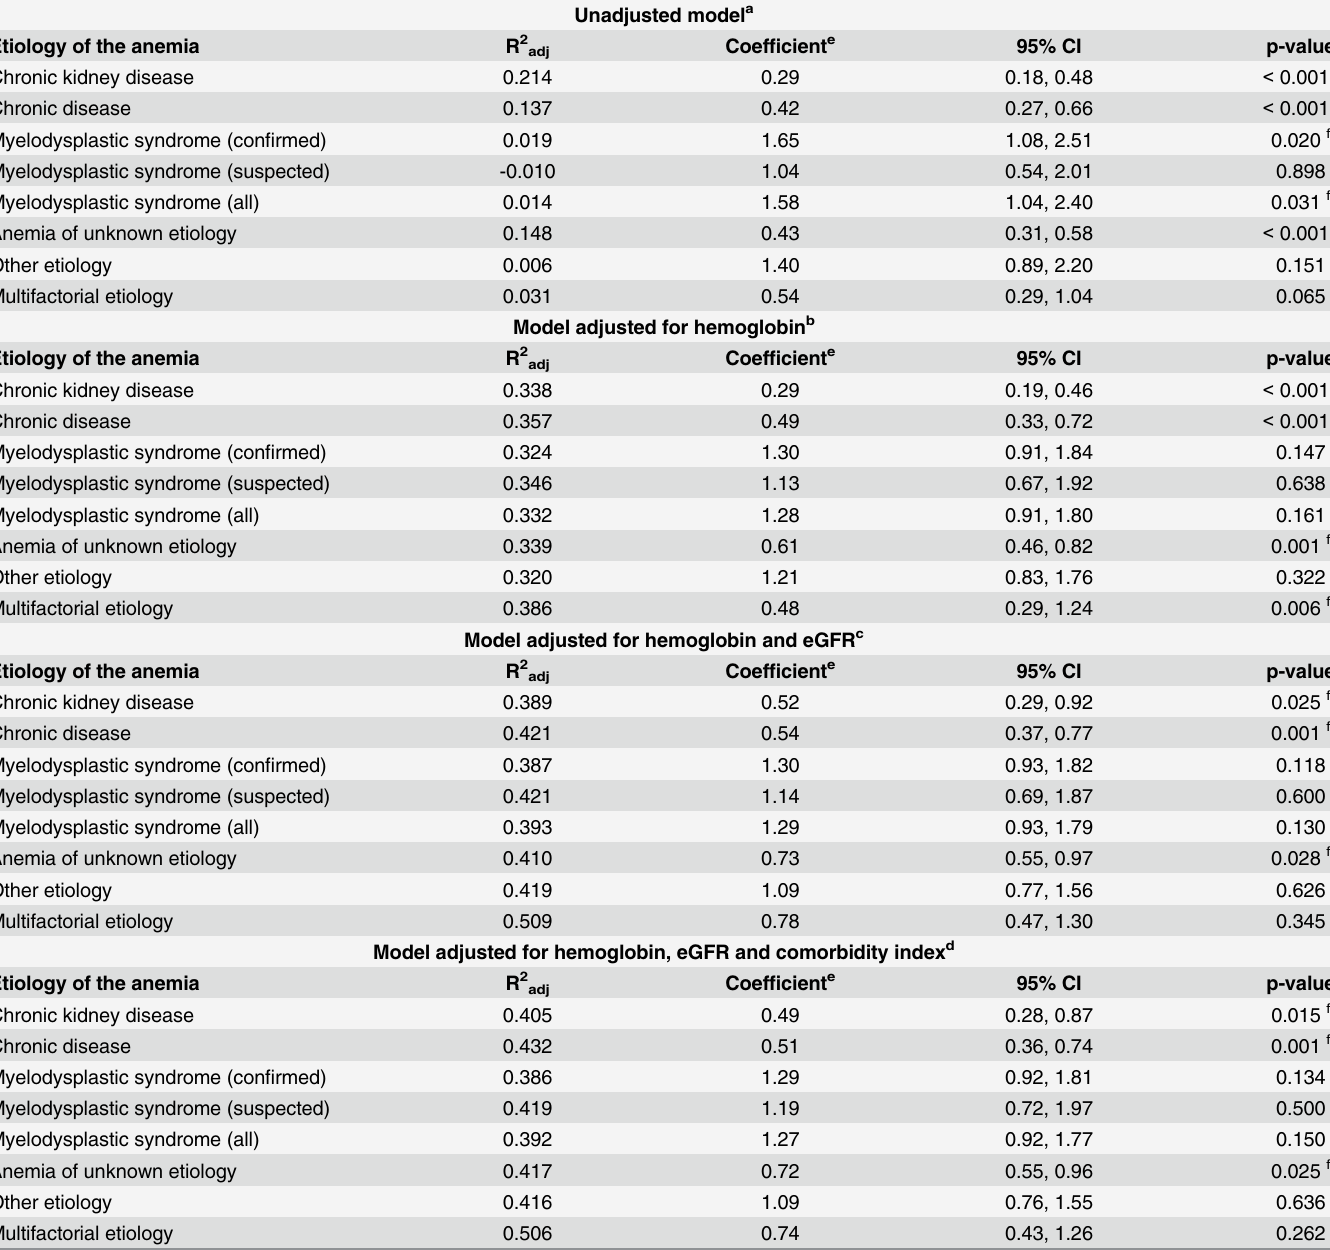
Table 3. Regression coefficients for unadjusted and adjusted models of EPO levels by